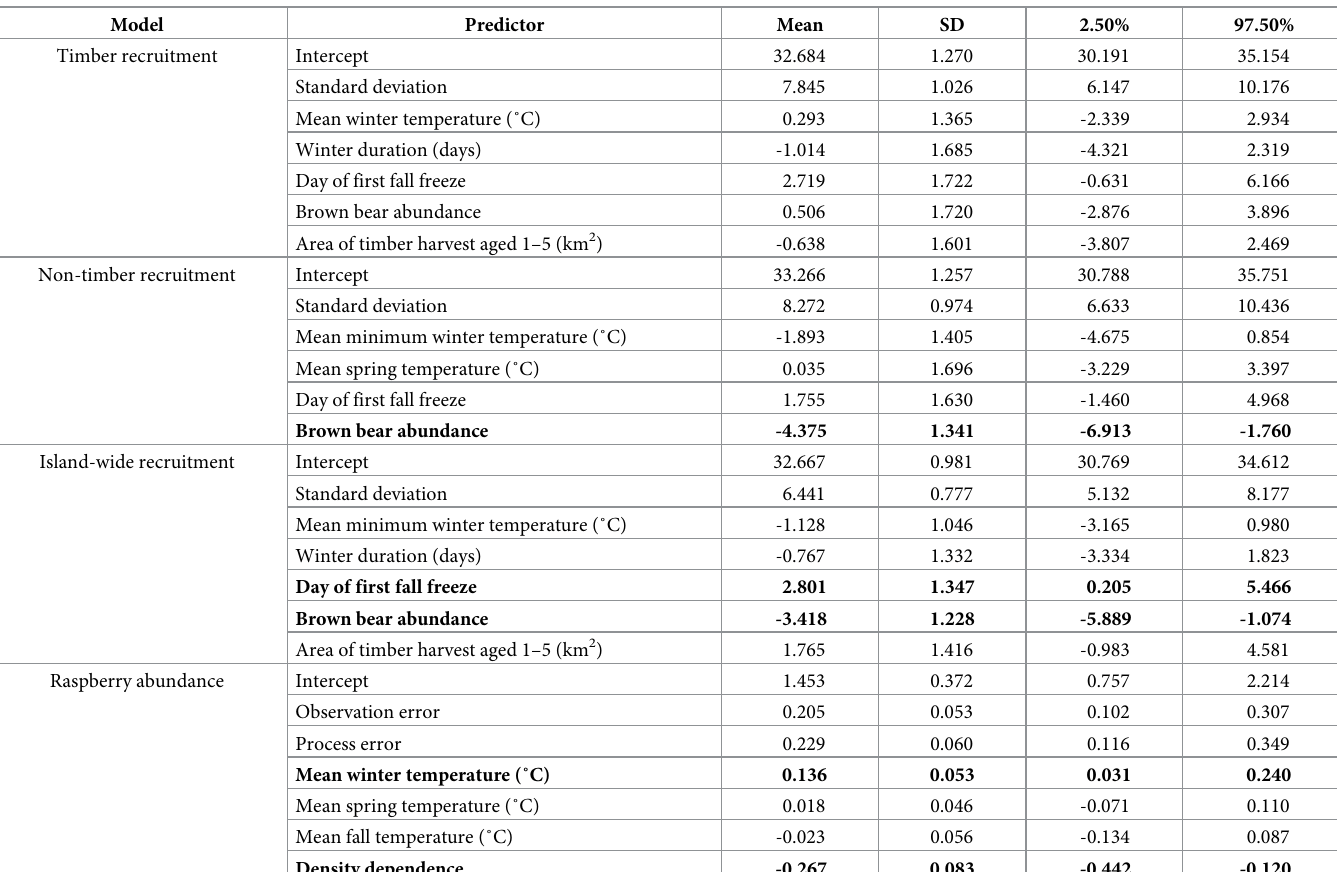
Table 3. Results from timber, non-timber, and island-wide elk recruitment and abundance